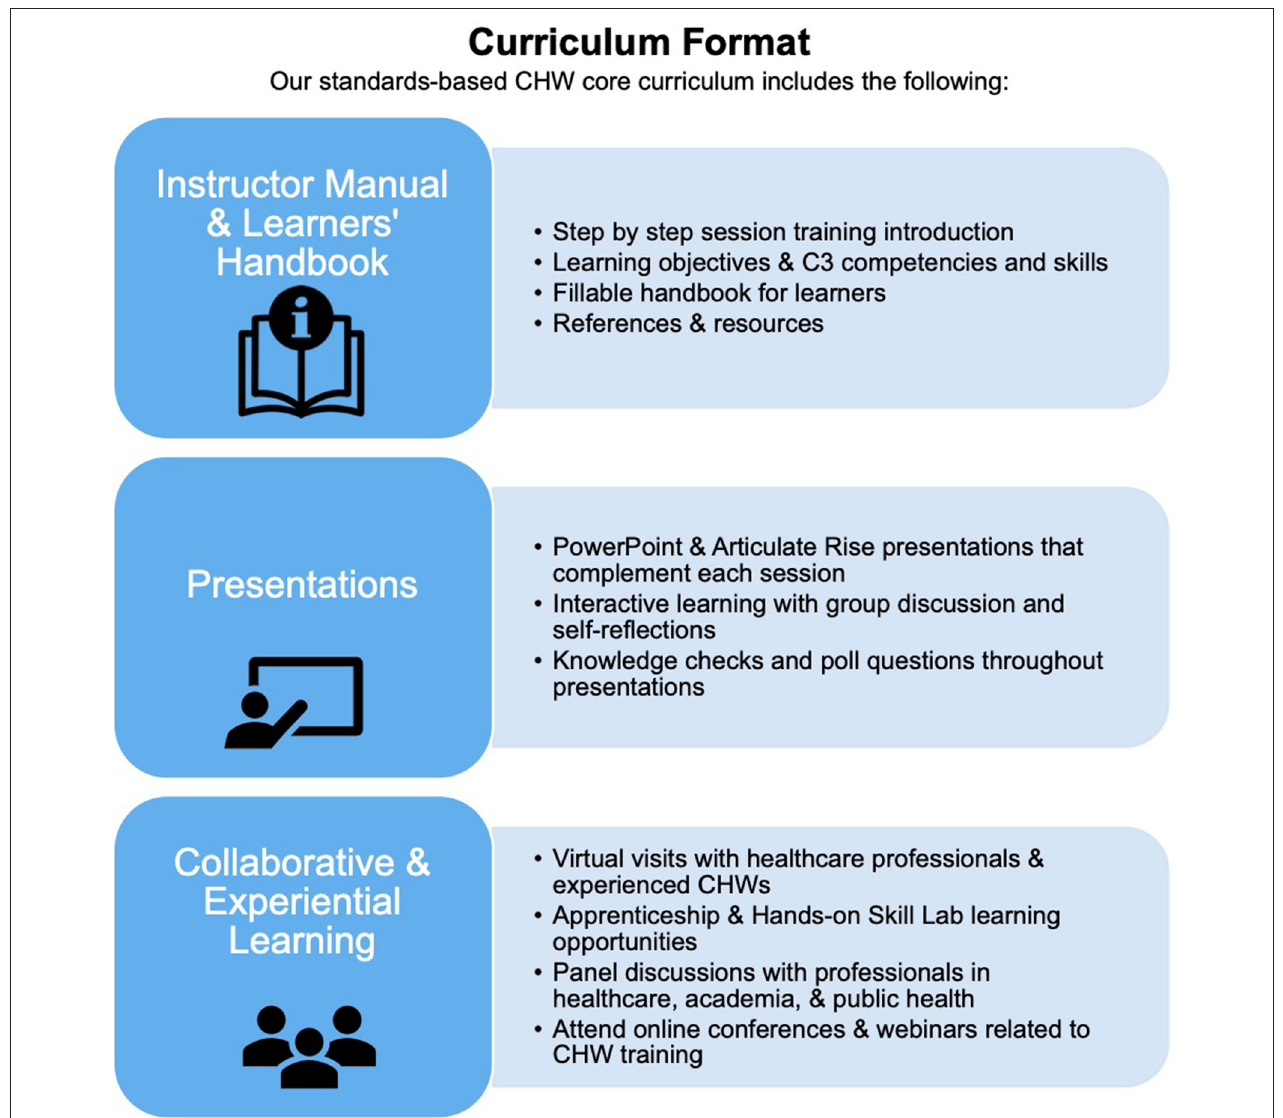
FIGURE 2 | CDU CHW academy core curriculum